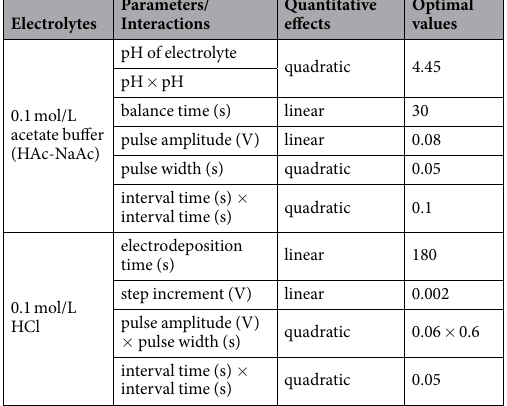
Table 1. Quantitative effects of significant parameters or interactions and their optimal